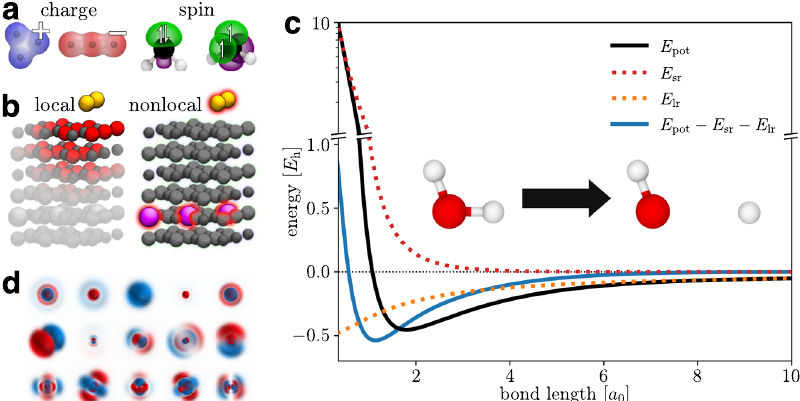
/Ag (cid:2) (left) and singlet/triplet CH 2 (right). 3 3